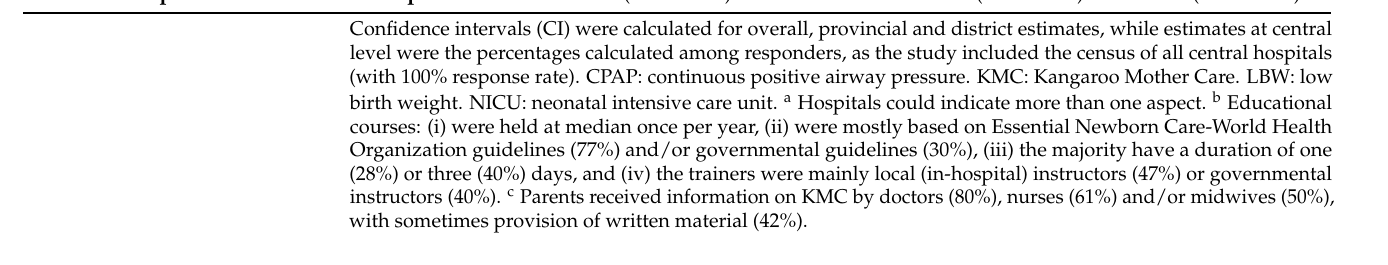
Table 3. Practical aspects of Kangaroo Mother Care (in hospitals where KMC is routinely performed or planned to be introduced in the next 12